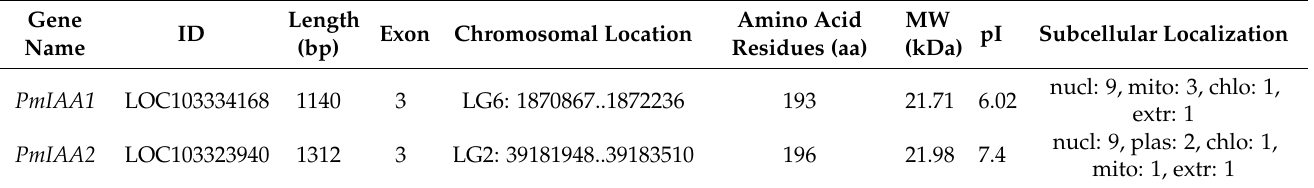
Table 1. Physiological and biochemical properties of PmIAA